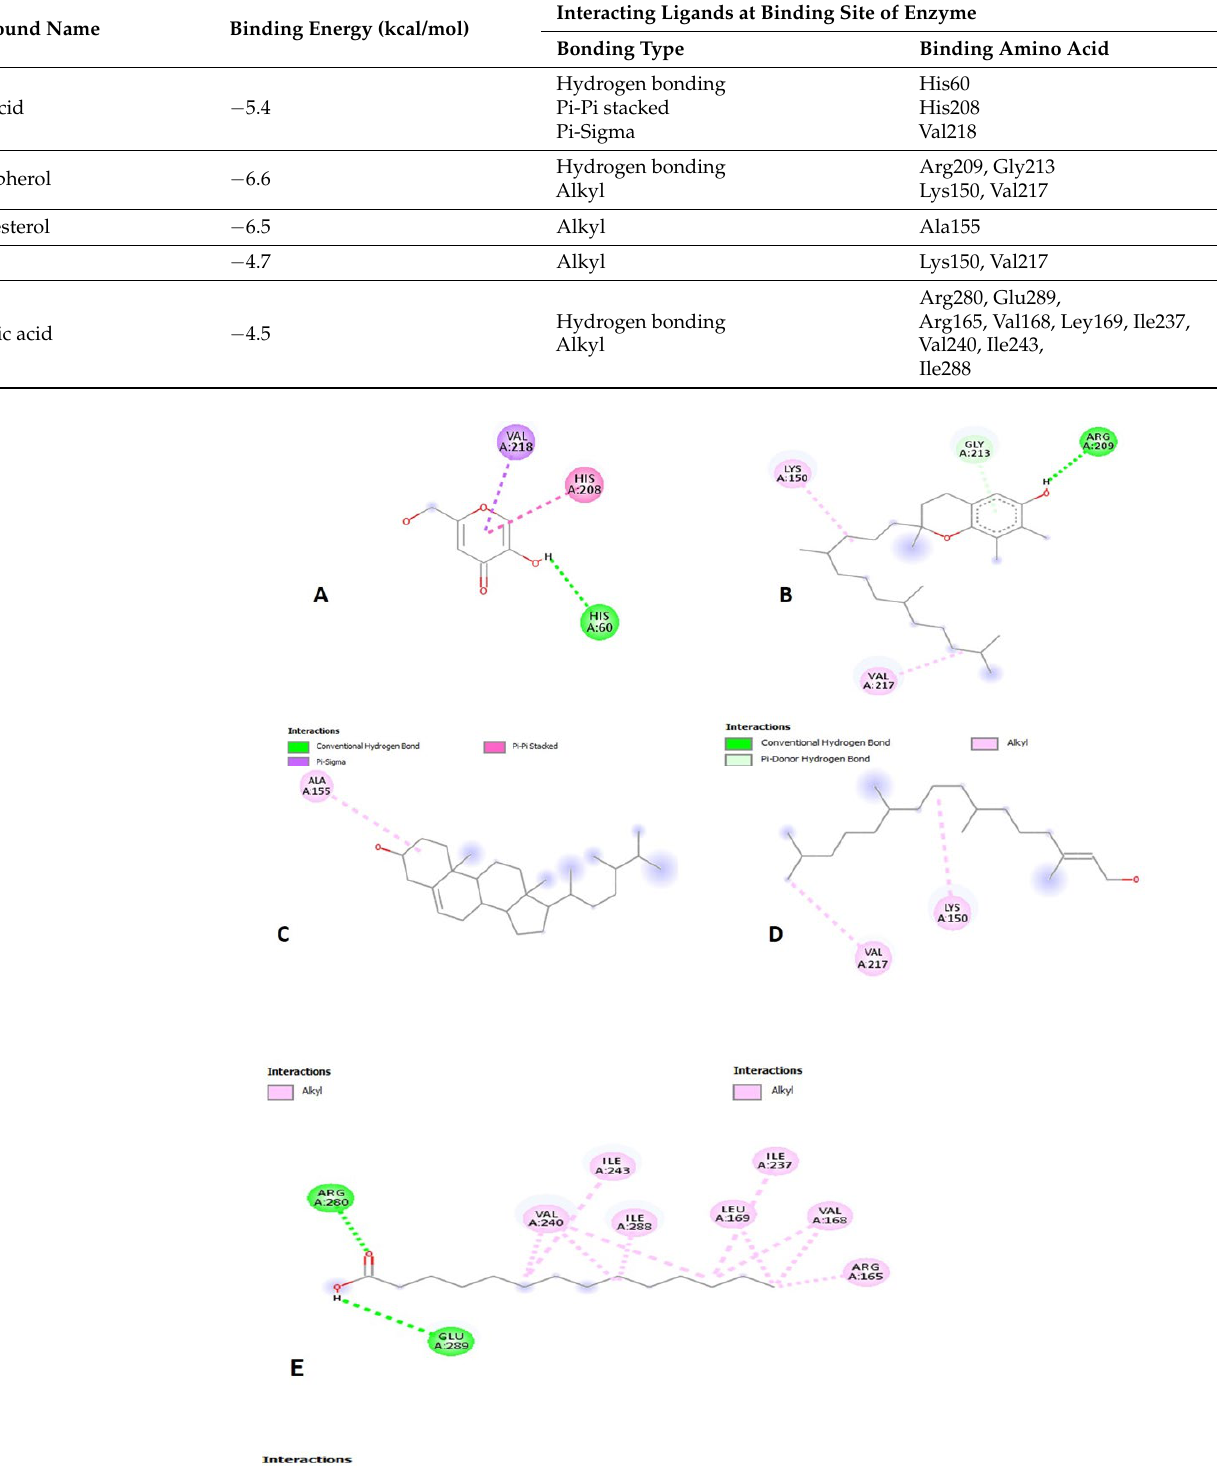
Figure 10. Interaction of tyrosinase ligands. ( A ) kojic acid, ( B ) γ -tocopherol, ( C ) campesterol, ( D ) phytol, and ( E ) myristic acid.